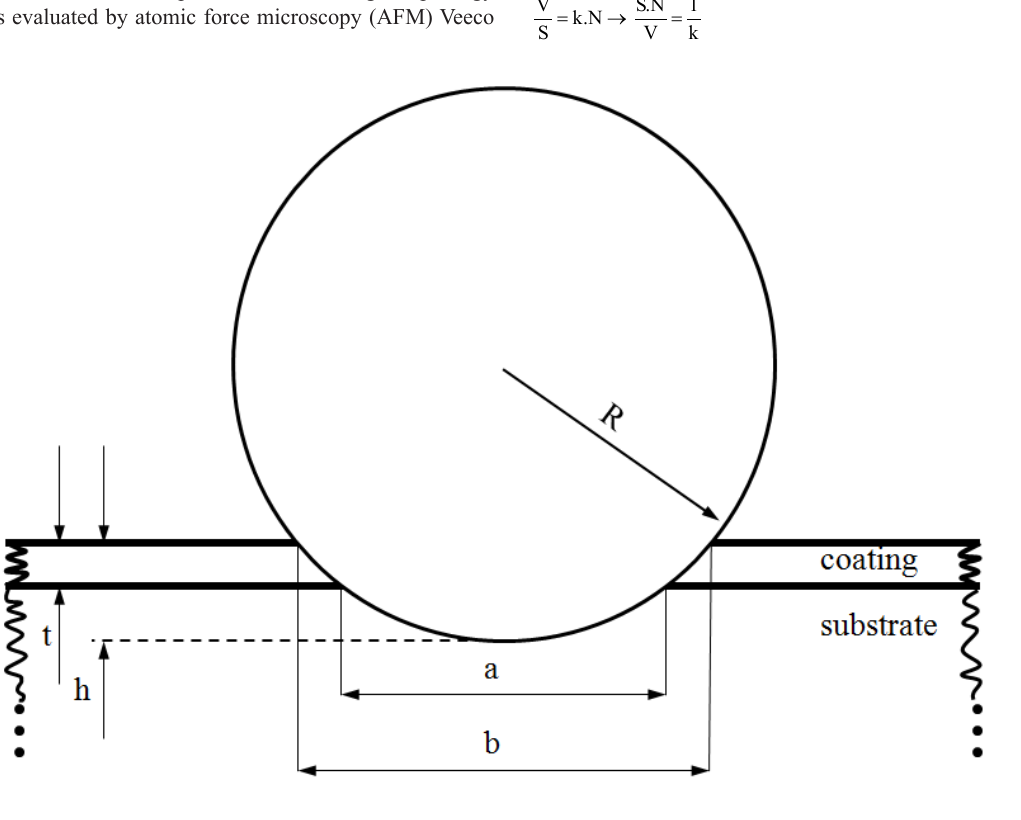
Figure 1. Schematic diagram showing the geometry of wear scars formed by micro-scale abrasion testing with a sphere of radius R in a coated